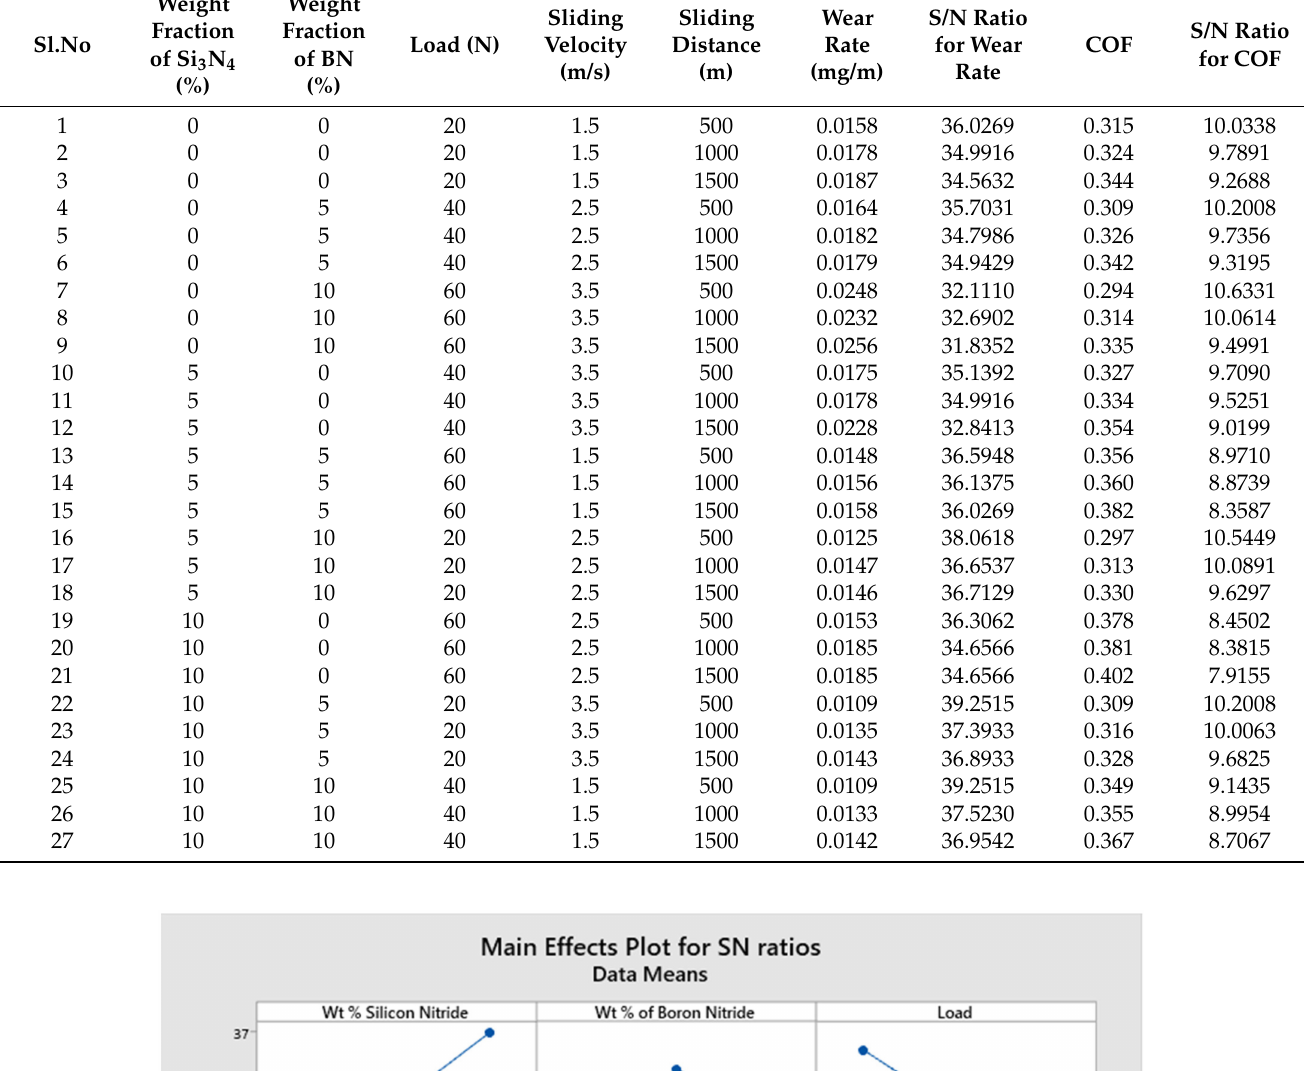
Table 5. L 27 Taguchi design with response parameters and S/N ratios.